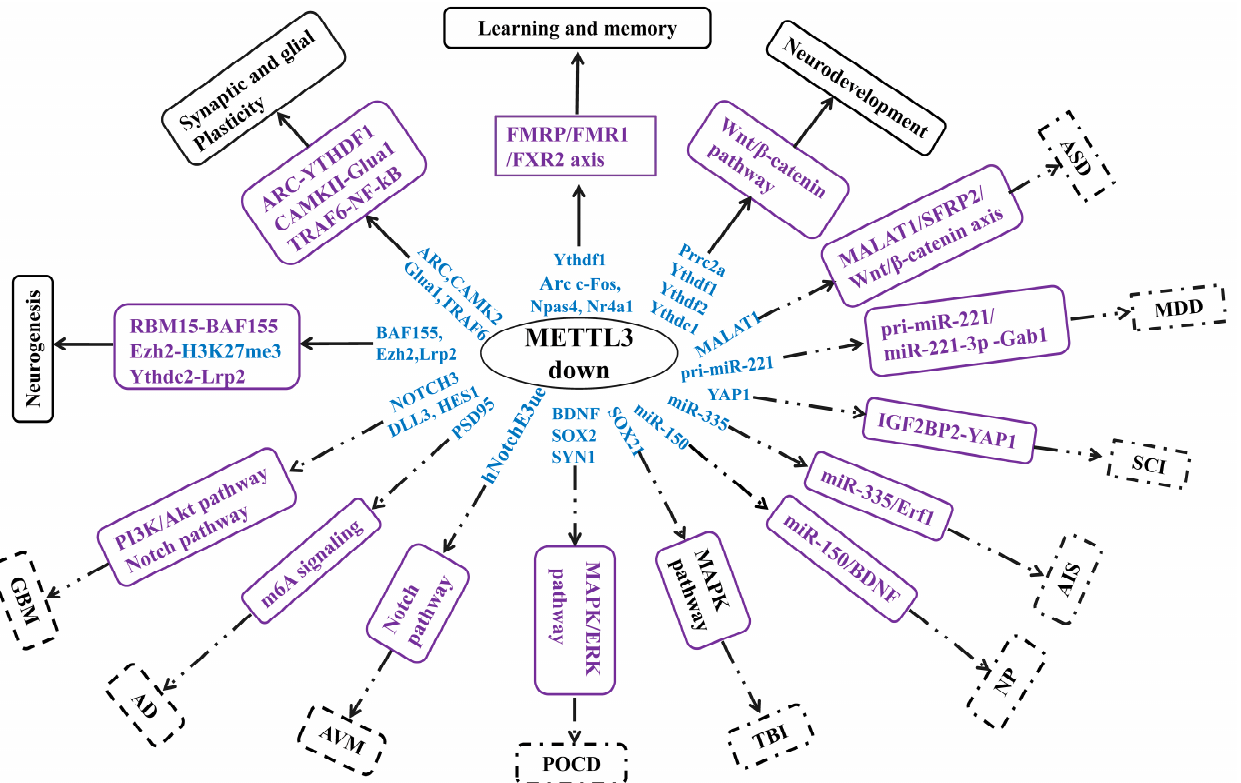
Figure 2. Illustration of the regulatory network of METTL3 in the nervous system. The targets and signaling pathways of METTL3 in neurophysiological and neuropathological events are summarized. We found that low expression of METTL3 exhibits different effects, which exert beneficial roles to promote neurological events such as promoting neurogenesis, while possibly exacerbating neuropathological events, such as worsening GBM. Blue wording, targets.